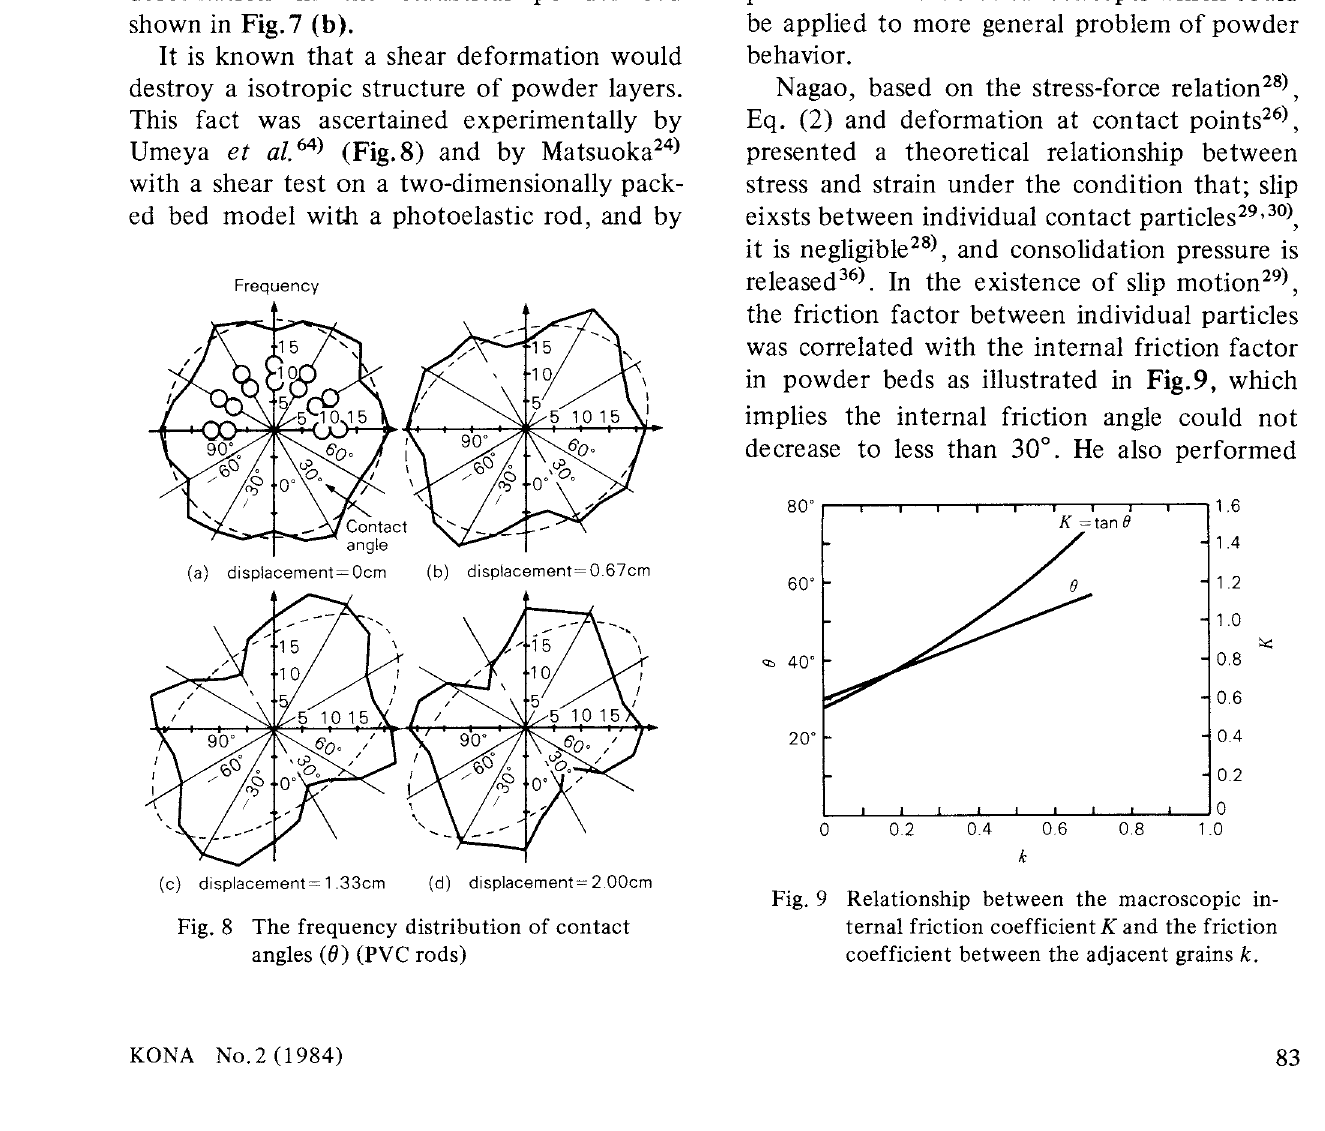
Fig. 8 The frequency distribution of contact angles ((J) (PVC rods)